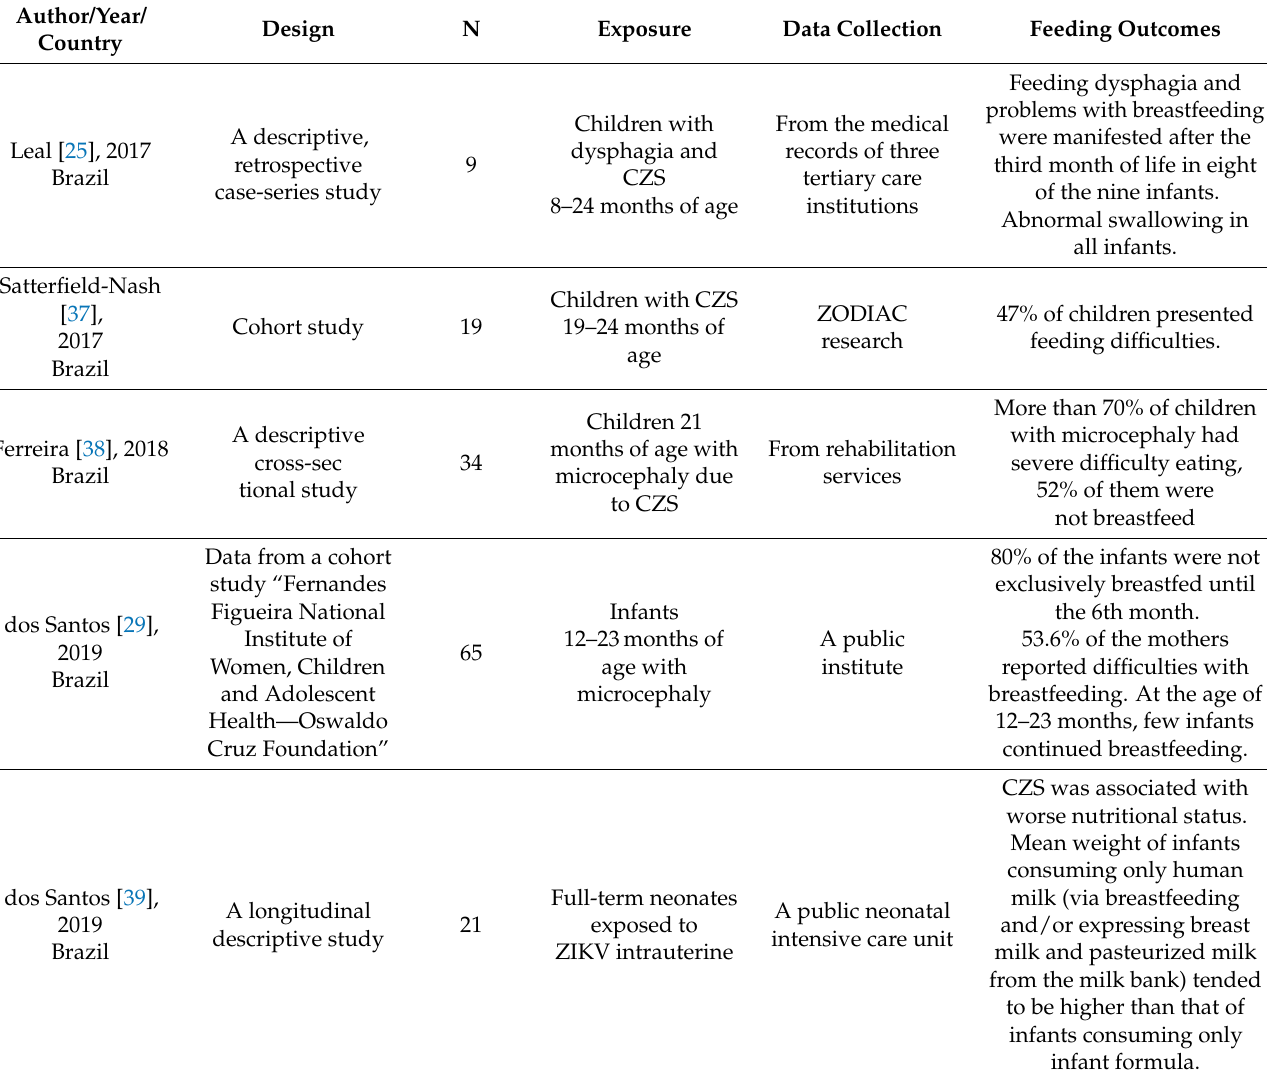
Table 2. Research studies included in the